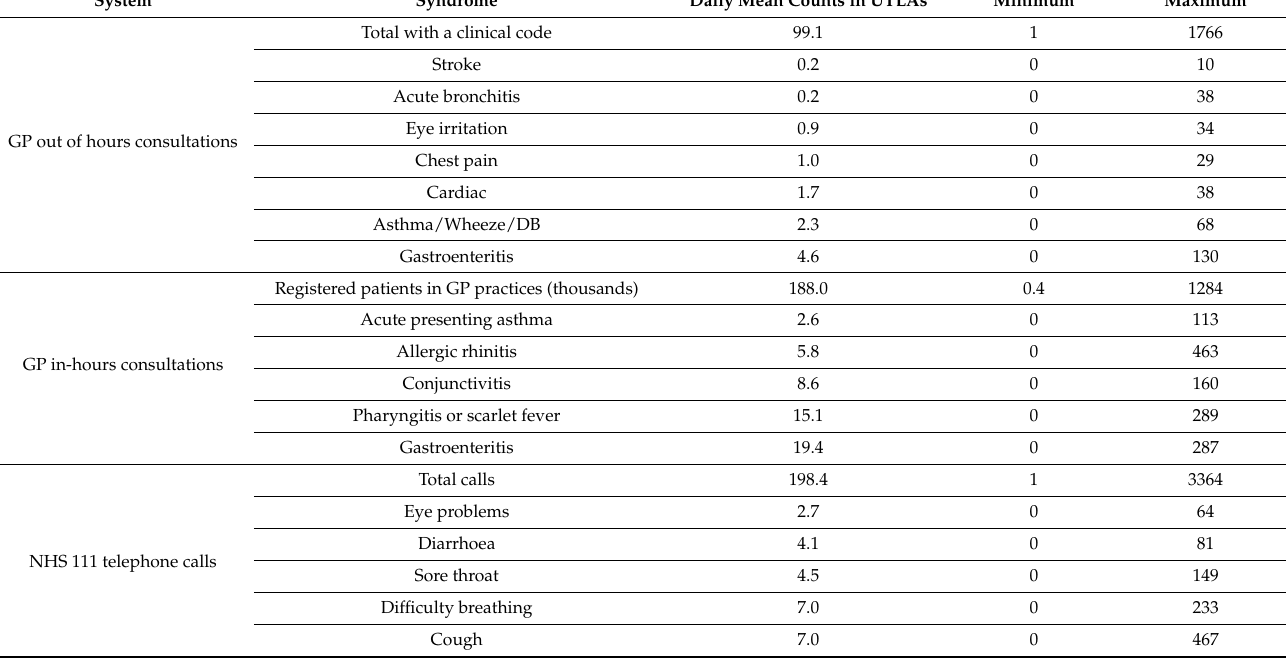
Table A2. Volume of daily syndromic UTLA data 2012–2017 by